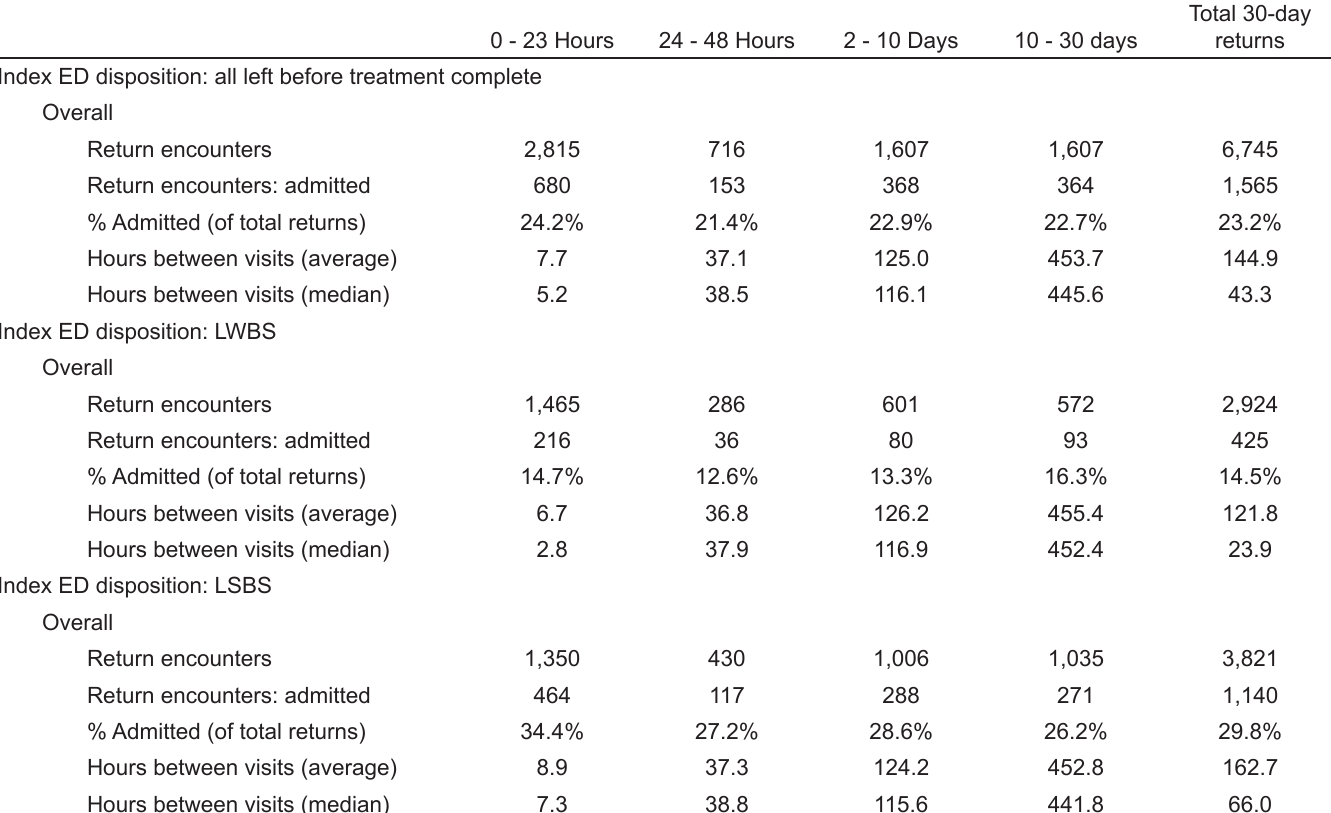
Table 3. Comparing dispositions when patients left without being seen vs. who left subsequent to being seen.